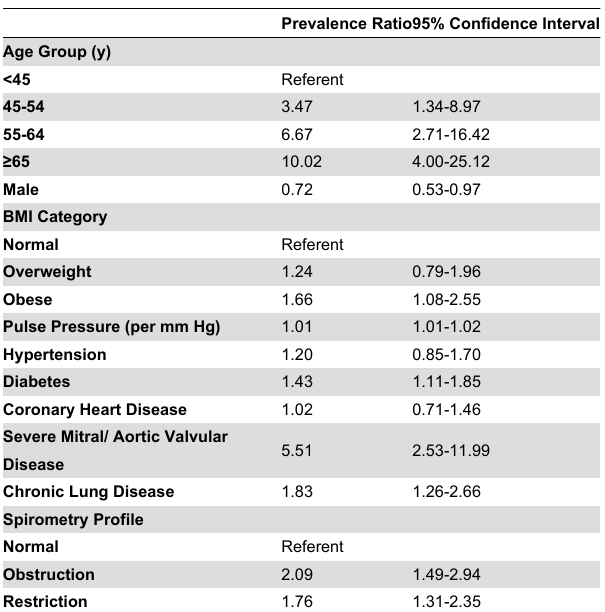
Table 3. Association of Demographic and Clinical Characteristics with Presence of Pulmonary Hypertension in Multivariate Analysis:.